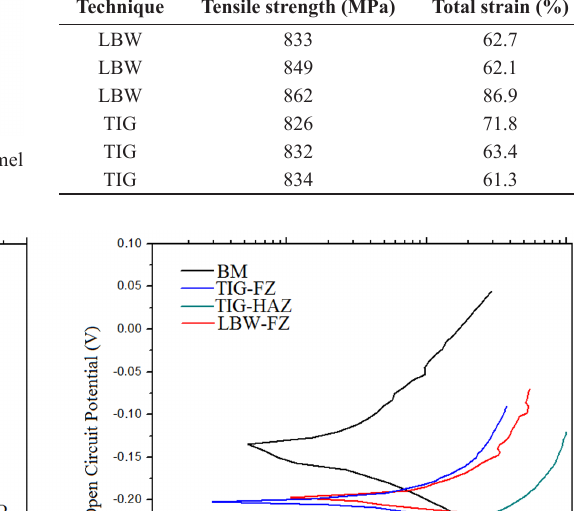
Table 2. Summary of the mechanical properties of the SAF-2507 samples.